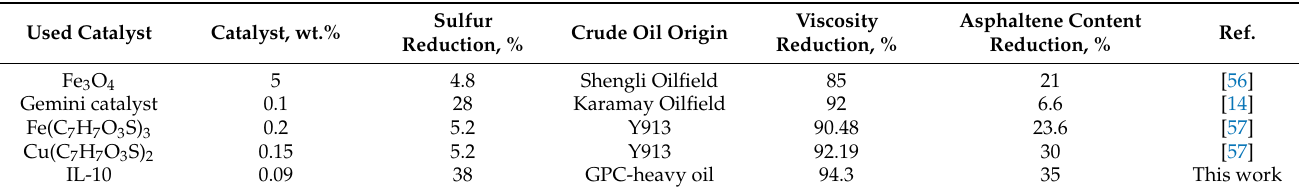
Table 5. Comparison between previously used catalysts and IL-10 in the catalytic aquathermolysis of heavy crude